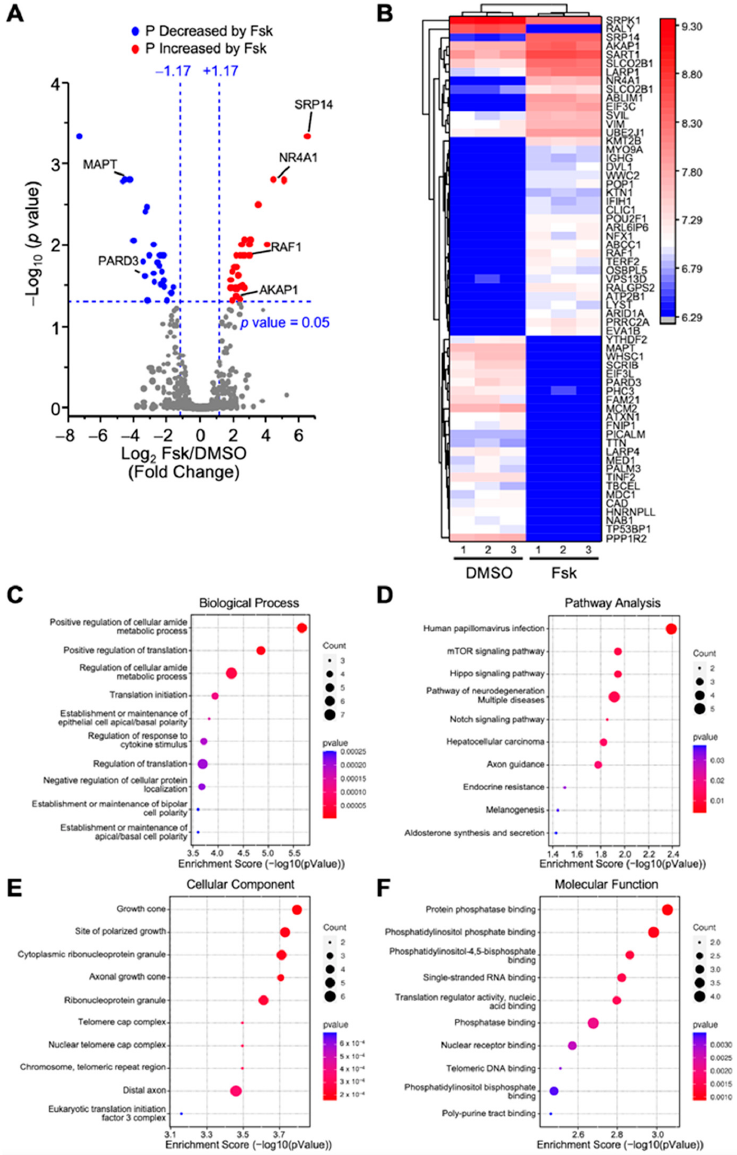
Figure 2. Analysis of differentially phosphorylated proteins in MA-10 Leydig cells in response Forskolin. LC-MS/MS was performed on enriched phosphopeptides extracted and digested from MA-10 Leydig cells treated with either DMSO (control) or Forskolin (Fsk, 10 µ m) for 1 h. Phosphorylated proteins were then quantified and compared between treatments. Results are the mean of three individual